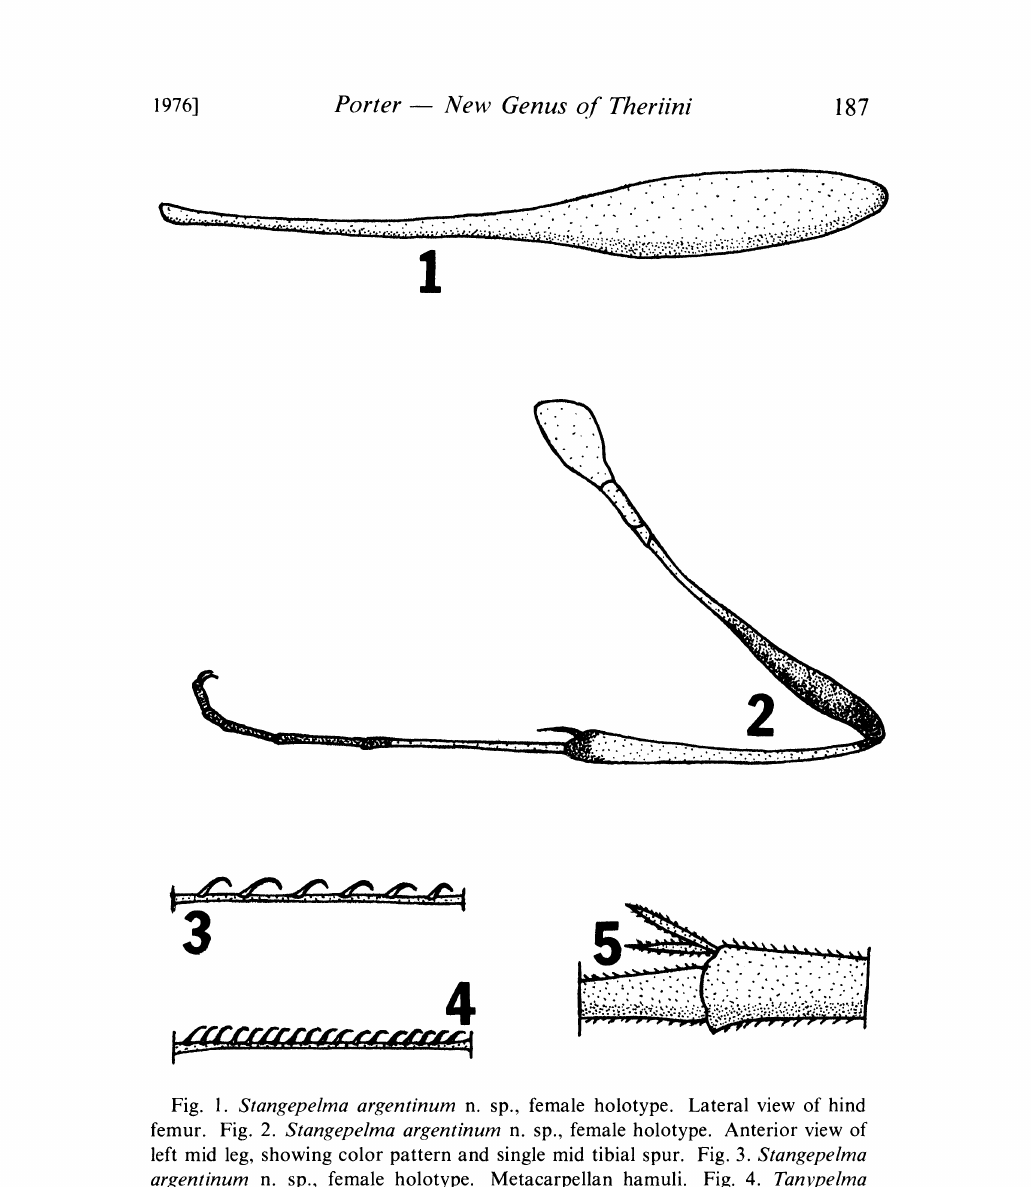
Fig. 1. Stangepelma argentinum n. sp., female holotype. Lateral view of hind femur. Fig. 2. Stangepelma argentinum n. sp., female holotype. Anterior view of left mid leg, showing color pattern and single mid tibial spur. Fig. 3. Stangepelma argentinum n. sp., female holotype. Metacarpellan hamuli. Fig. 4. Tanypelma fulvicorne Townes, female. Metacarpellan hamuli. Fig. 5. Tan.vpelmafulvicorne Townes, female. Apex of mid tibia and base of mid basitarsus, showing the two mid tibial